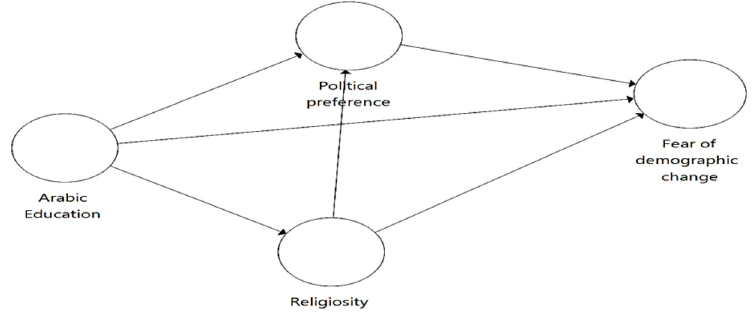
Figure 1. Conceptual framework (Source: authors’ formulation).